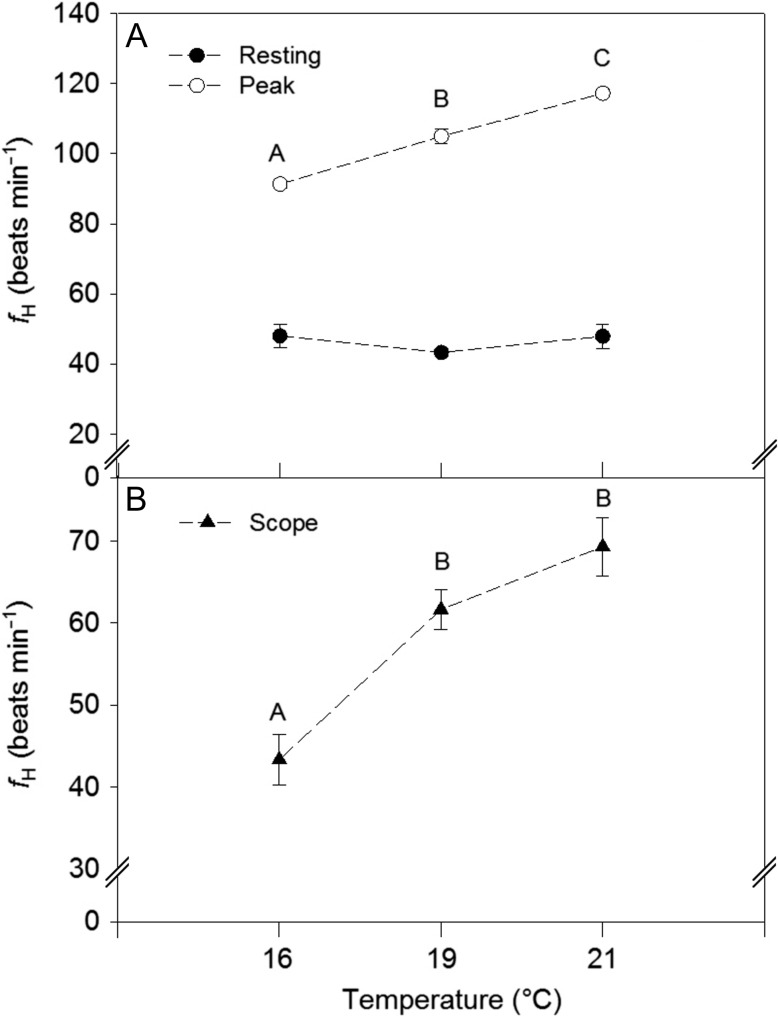
Mean (±SE) (A) resting heart rate (fH) and peak fH and (B) scope for fH (peak fH – resting fH) of sockeye salmon during a fisheries capture simulation, while exposed to 16°C (N = 13), 19°C (N = 13) and 21°C (N = 9) water temperatures. Differing letters indicate significant differences among temperature treatments (One-way ANOVA; P-value <0.05).